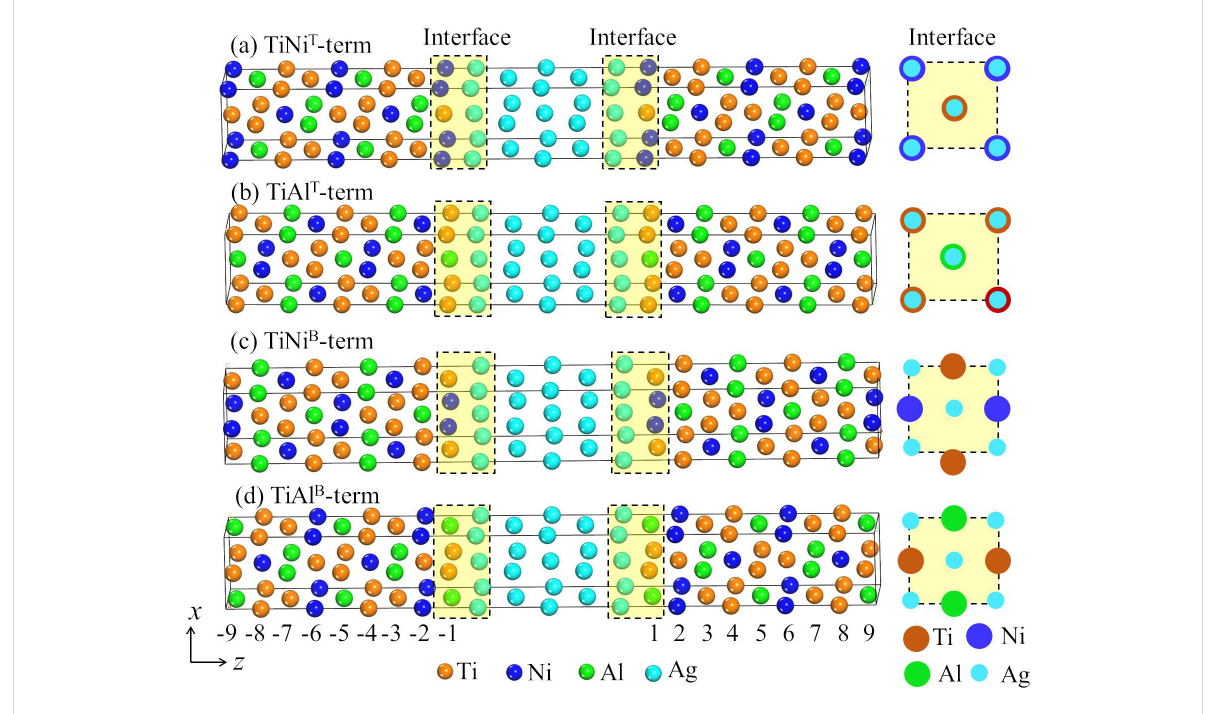
Figure 1: Schematic illustration of a Ti 2 NiAl/Ag/Ti 2 NiAl device with different atomic terminated interfaces. (a) TiNi T -terminated interface, (b)TiAl T - terminated interface, (c) TiNi B -terminated interface and (d) TiAl B -terminated interface.